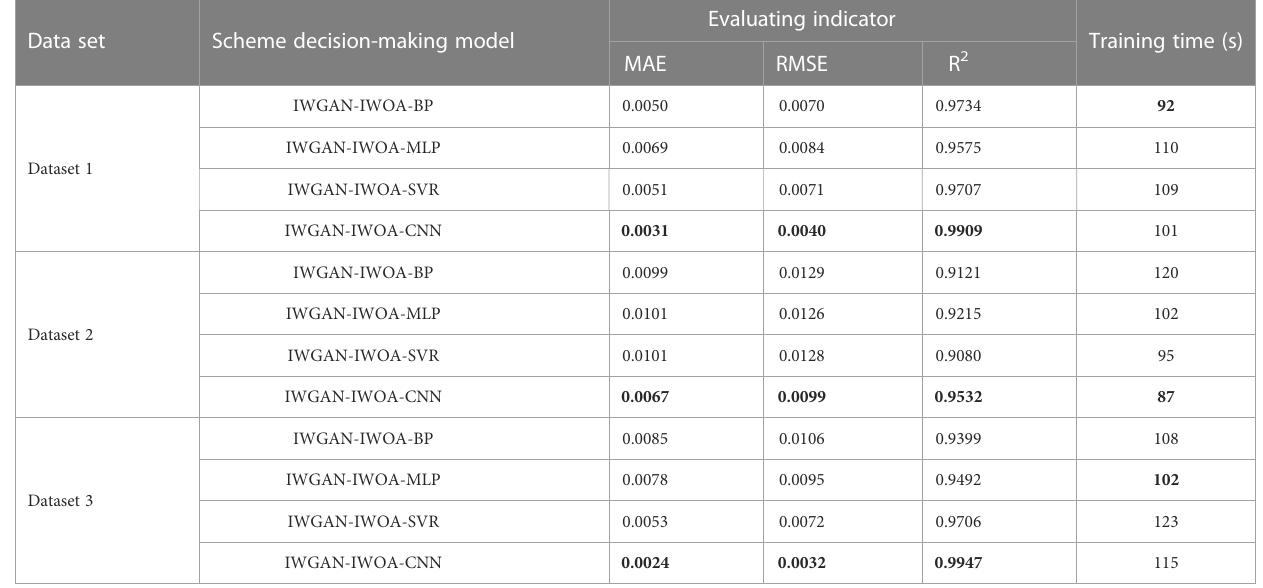
TABLE 5 Comparison of different scheme decision-making models.